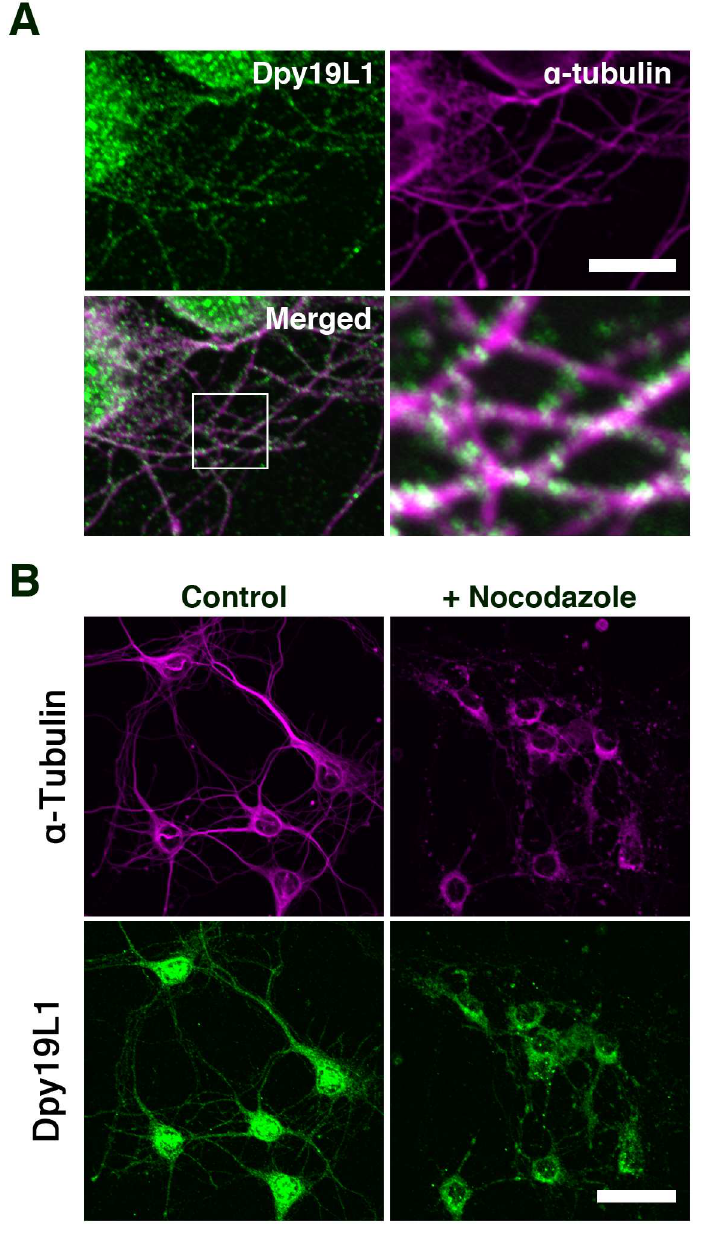
Fig 4. Distribution of Dpy19L1 along microtubules in embryonic cortical neurons. (A) Embryonic cortical neuronswere double-labeled with anti-Dpy19L1 (green) and anti- α -Tubulin antibodies (magenta). Lower panel shows the mergedimage. Boxed area is magnifiedin lower right image. (B) Primary cortical neuronswere treated with nocodazole. The cytoplasmic reticular pattern of Dpy19L1is perturbedby nocodazole treatment. Results shown were obtainedfrom three independentcultures. Scale bars: 10 μ m in A and 30 μ m in